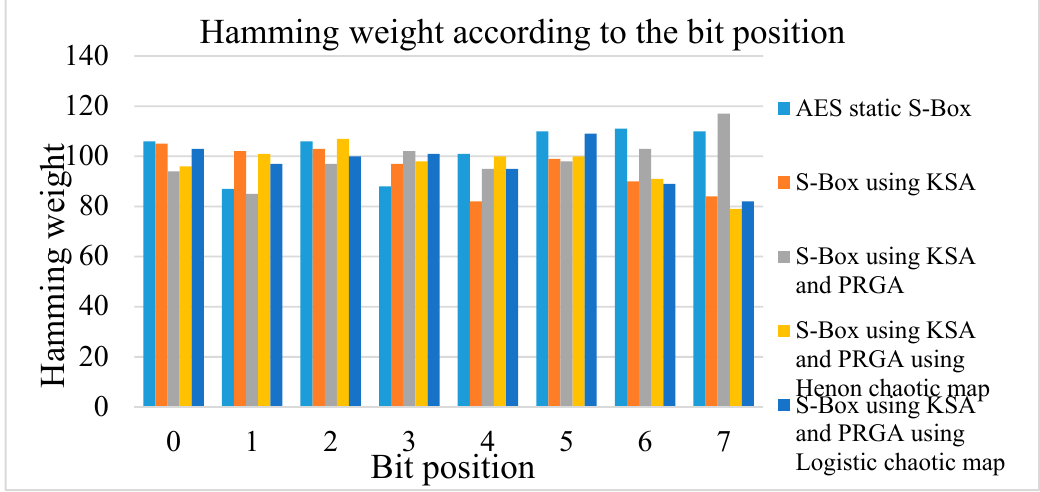
Figure 13. Analysis of Hamming weights according to the bit position for the five S-Boxes with the key “F9E8D7C6B5A40123”.